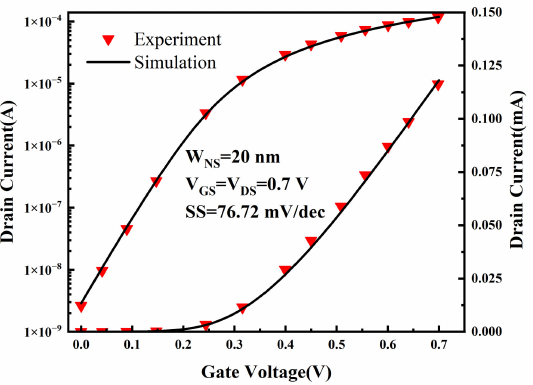
Figure 2. I d -V g calibration of 3-stacked nanosheet structure with the SHE considered.